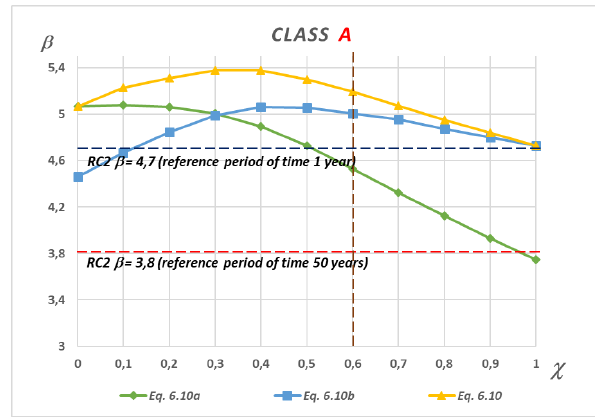
Figure 1: Reliability coeflcient curves β and load factor χ for the class A execution of works and three different combinations of standard coeflcients (formulas: 6.10a, 6.10b, 6.10) - reliability class